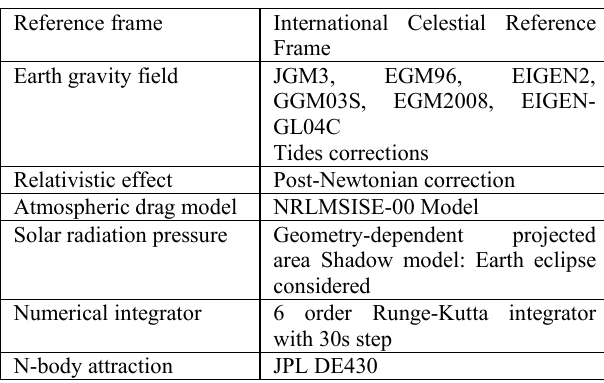
Table 2. Orbit models used in this paper.